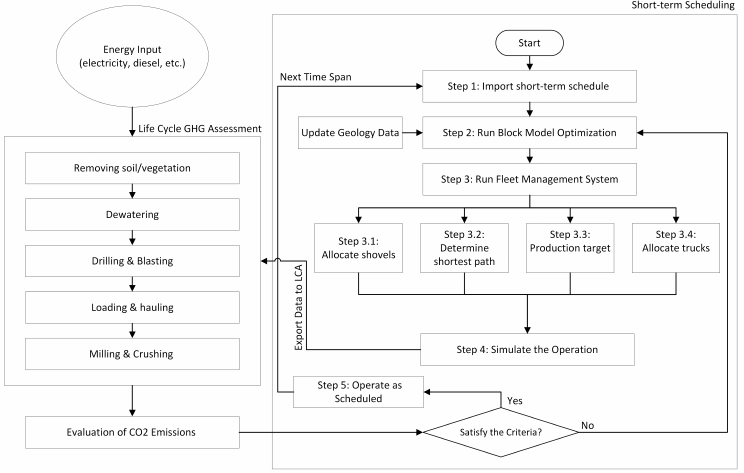
Figure 2. Schematic flow chart of integrated short-term planning with